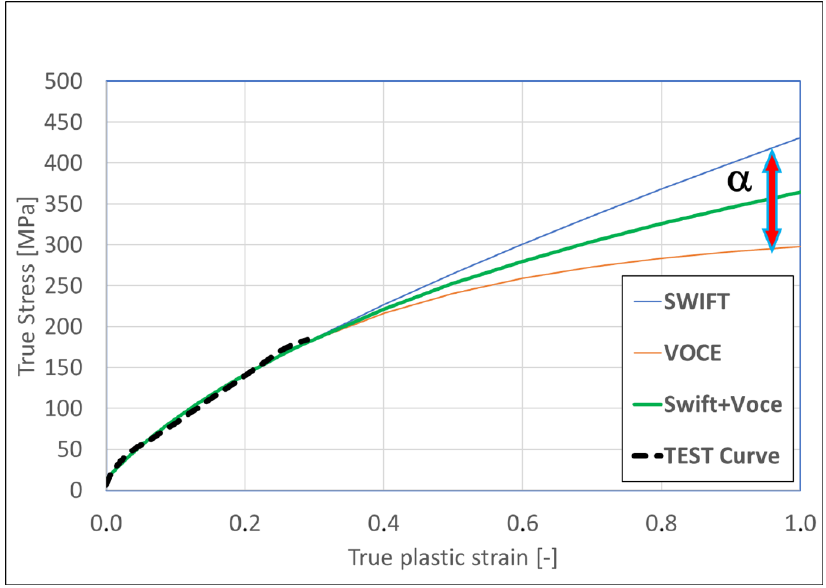
Figure 9. Extrapolation using the interpolation function (green) between the Voce (yellow) and Swift (blue) functions.